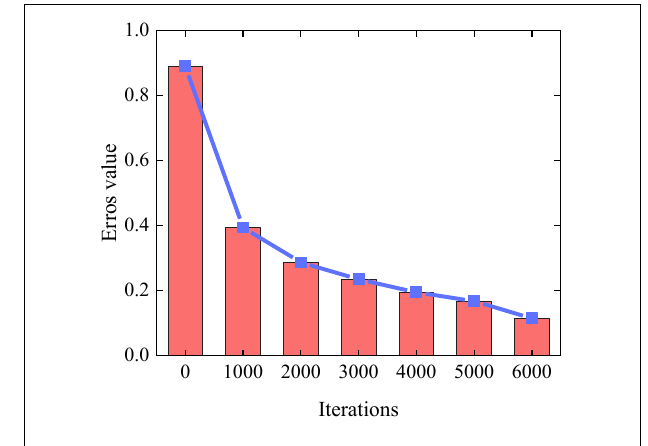
FIGURE 6 | Influence of different iteration times on training effect.